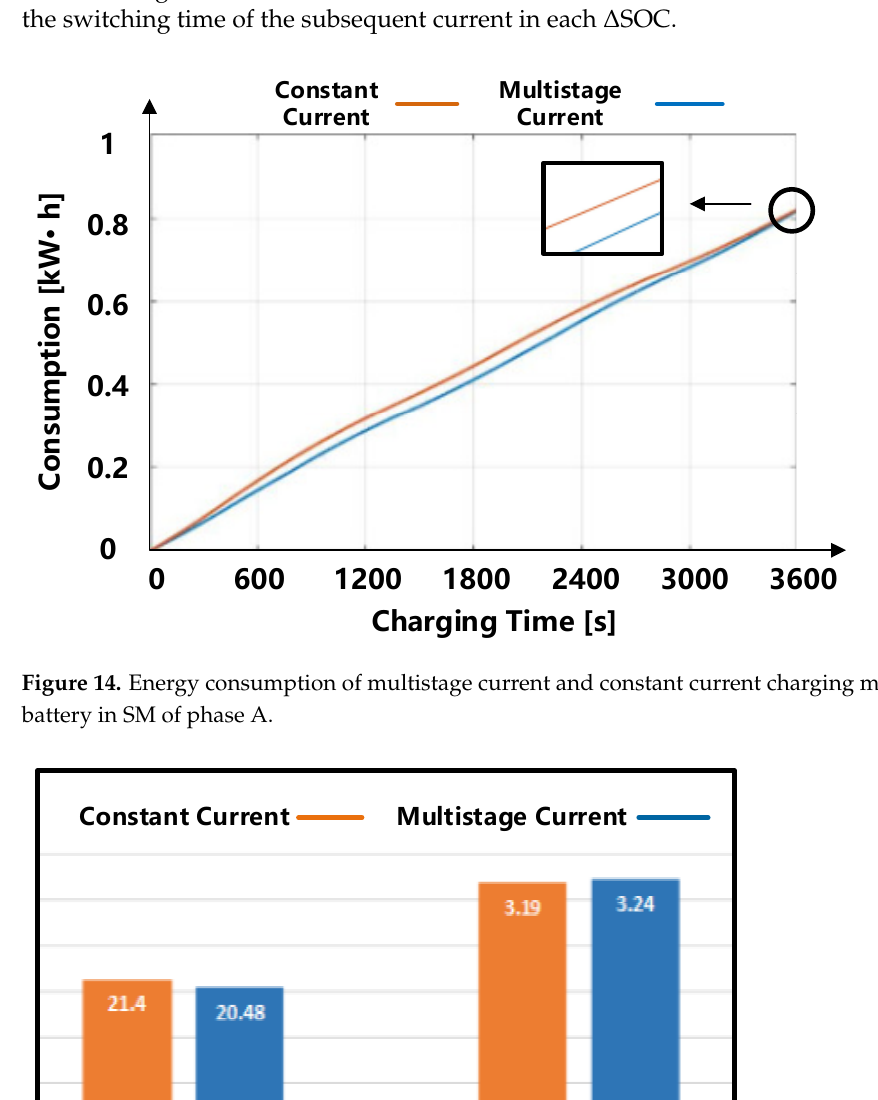
Figure 13. Power of energy consumption of multistage current and constant current charging method of one battery in SM of phase A.